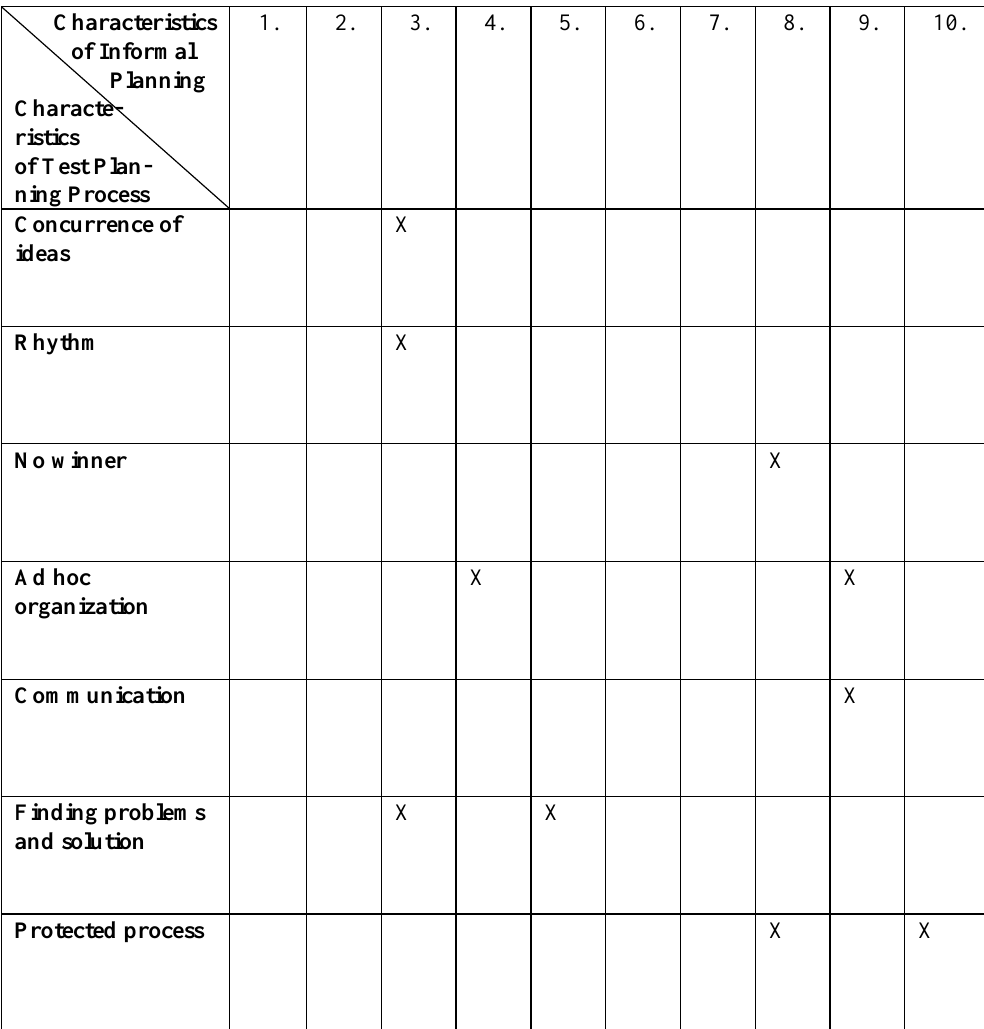
Table 2. Co-relation of the Characteristics of Informal Planning and the Existing Test Planning Process (developed by the